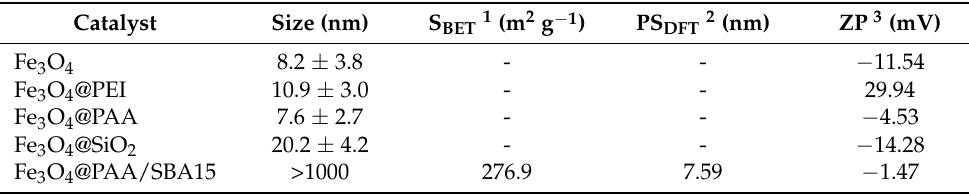
Table 1. Properties of the different nano-catalysts used in this work.